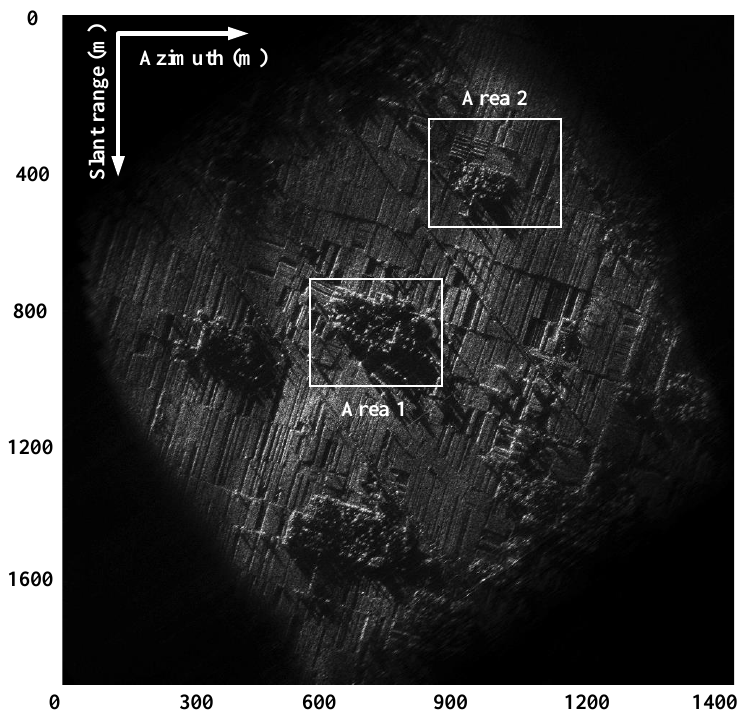
Figure 13. Squint SAR image with the proposed error